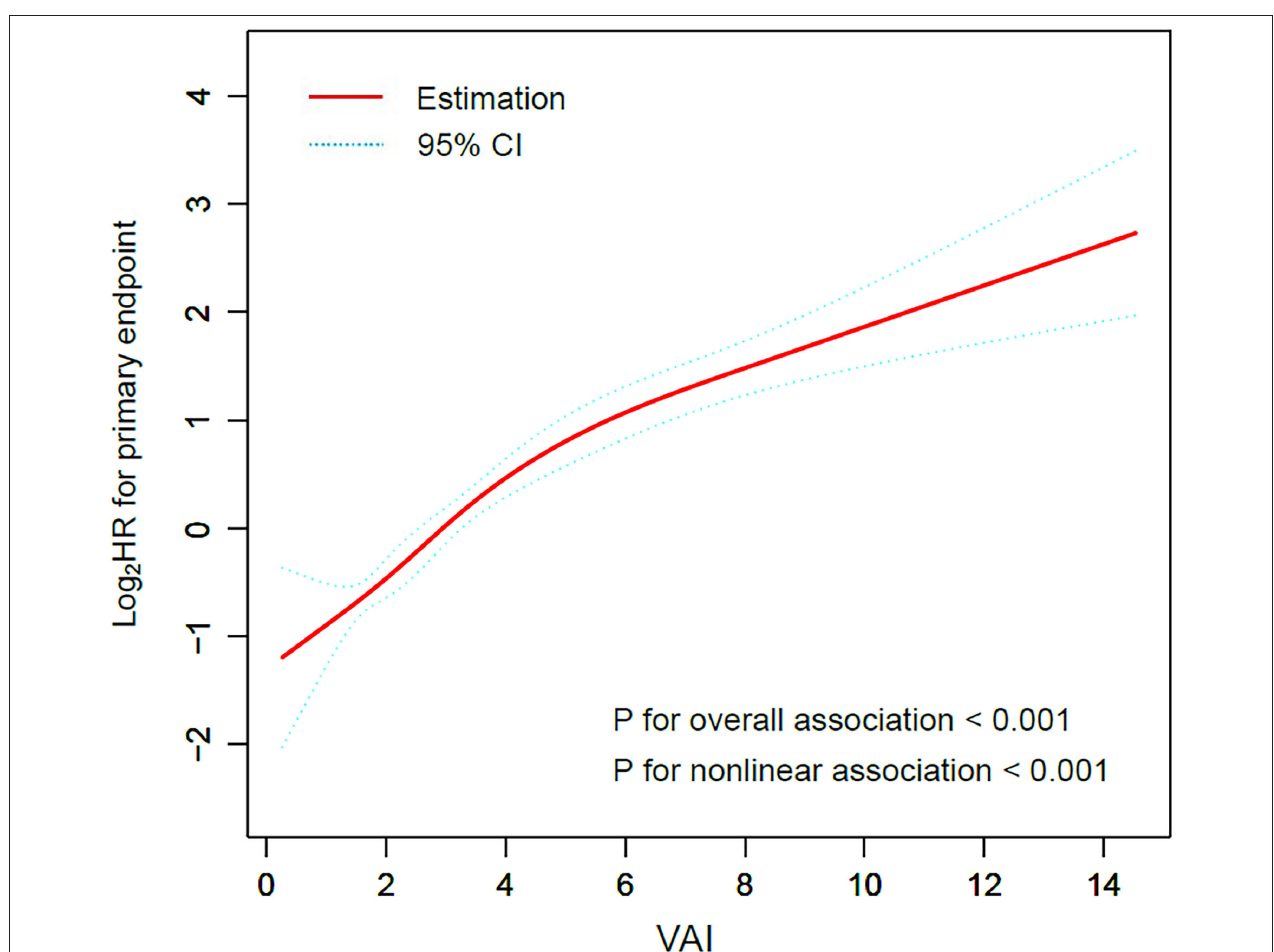
FIGURE 2 | Restricted cubic smoothing for the risk of the primary endpoint according to the VAI. The analysis was adjusted for model 5. HR was evaluated by per 1-unit increase of VAI. VAI, visceral adiposity index; HR, hazard